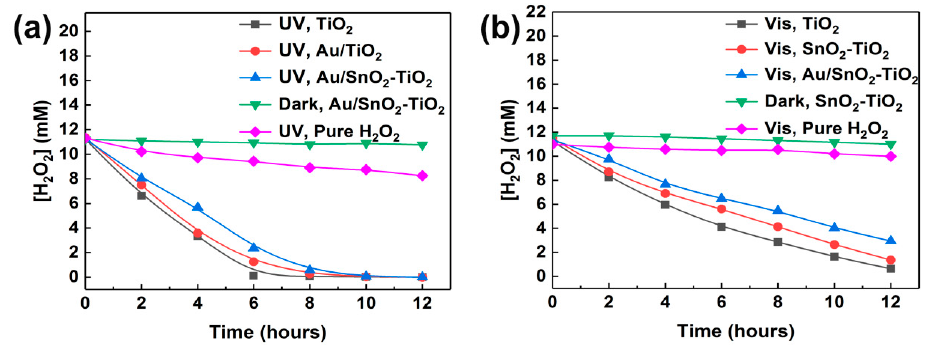
Figure 4. H 2 O 2 photodecomposition under UV light ( a ) and visible light ( b ) conditions.